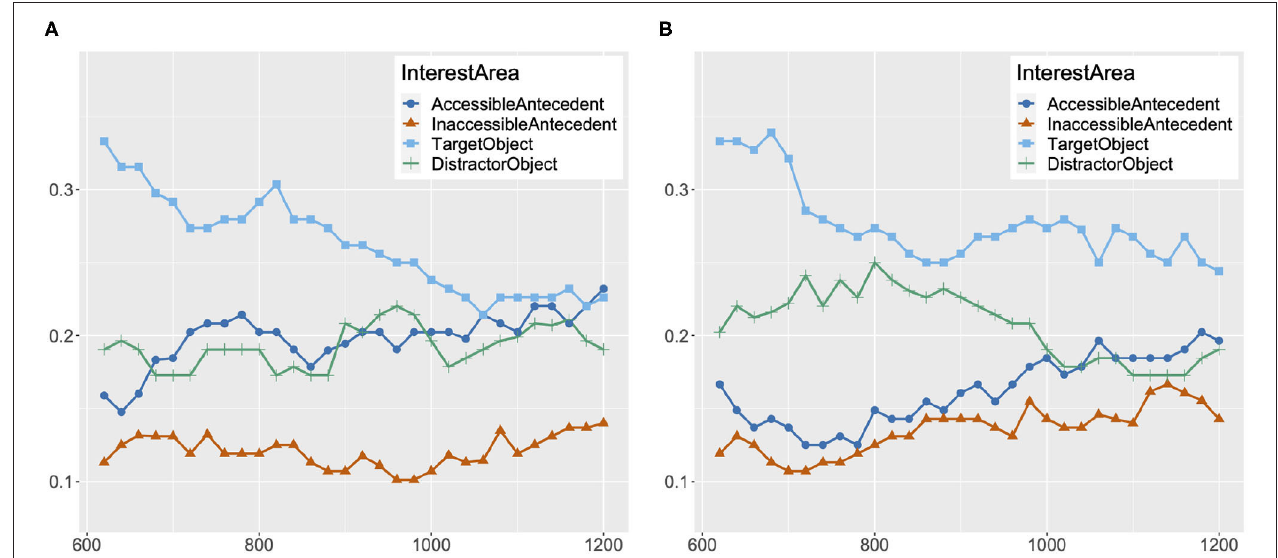
FIGURE 7 | Proportion of looks to accessible antecedent, inaccessible antecedent, distractor object and target object image in single match condition at every 20 ms from 601 to 1,200 ms after the onset of the target anaphor, Experiment 2. (A) Proportion of Looks: Reflexive, Single Match. (B) Proportion of Looks: Pronoun, Single